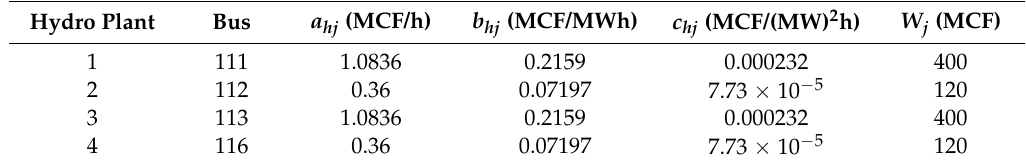
Table A3. The data of hydro units included in the IEEE 118 buses system.